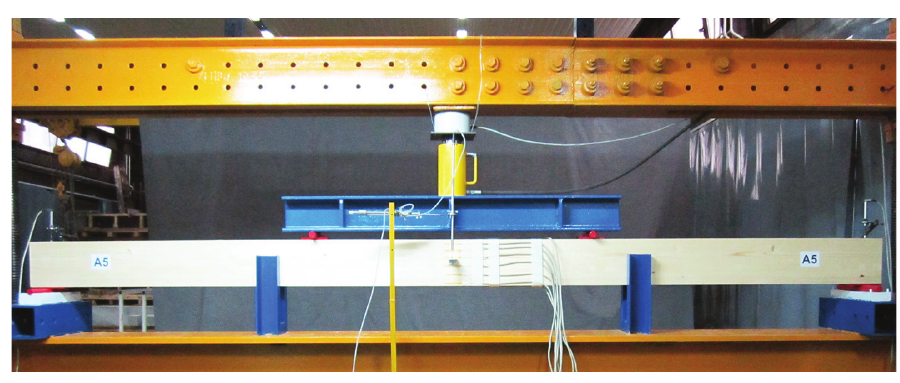
Fig. 2. Test set-up